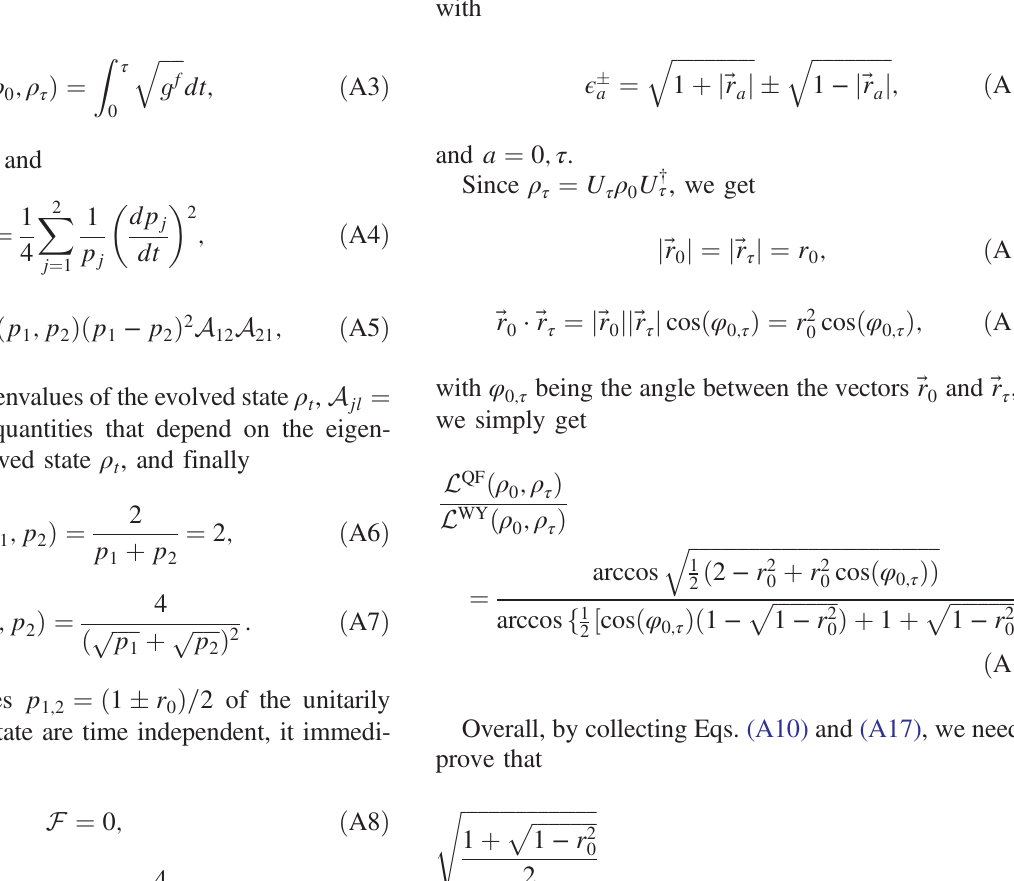
ffiffiffiffiffiffiffiffiffiffiffiffi p 1 − r 2